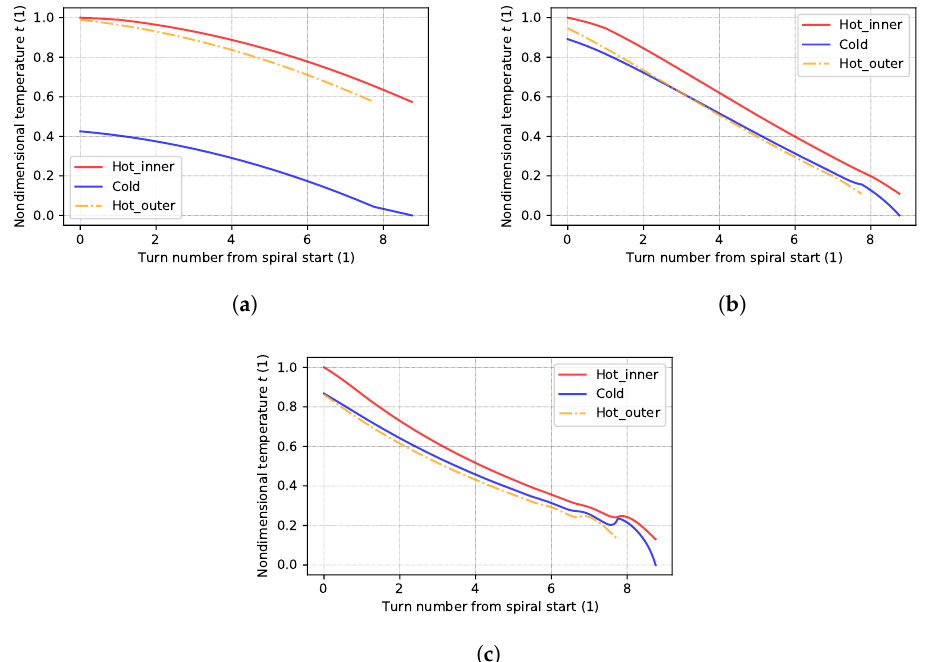
Figure 6. Predicted temperature profile in one-module SPHE with geometry from Strenger et al. [9]. ( a ) Low NTU. ( b ) Optimal NTU. ( c ) High